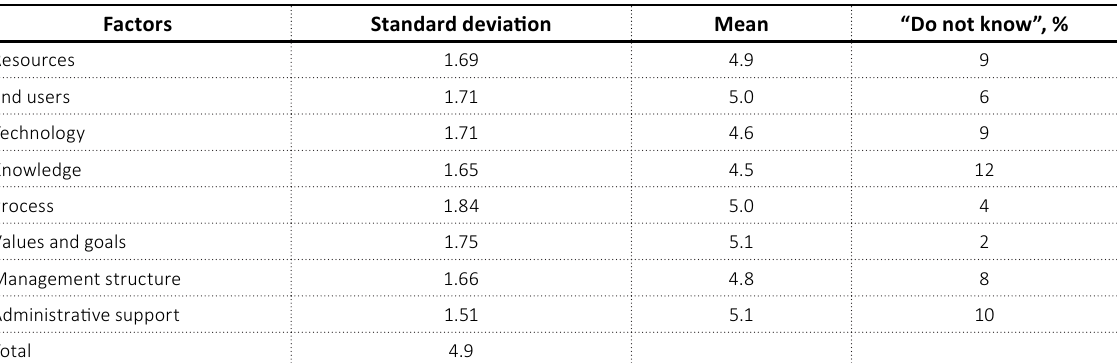
Table 11. Internal readiness